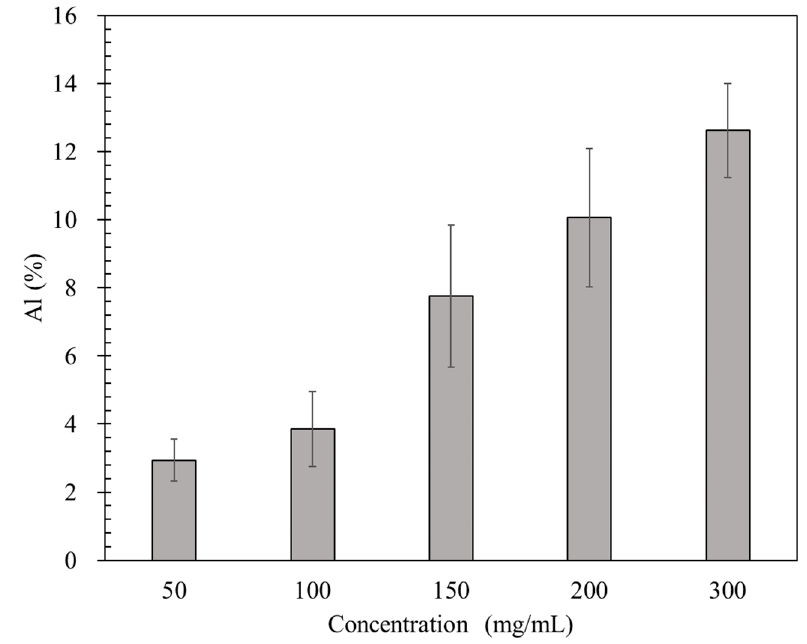
Figure 4. Percentage of Al with different concentrations for 500 s of exposure.